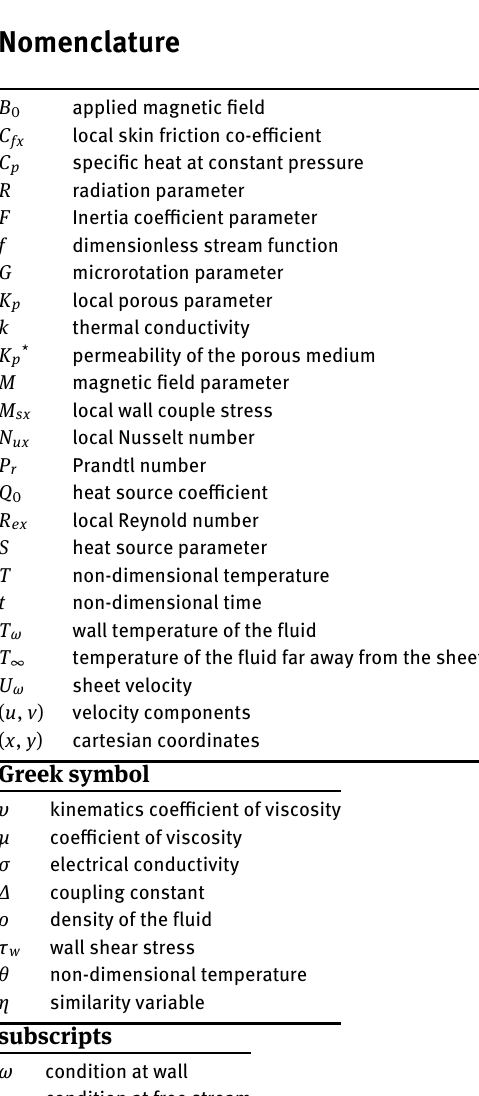
Fig. 10: Temperature profile for different values of S and R